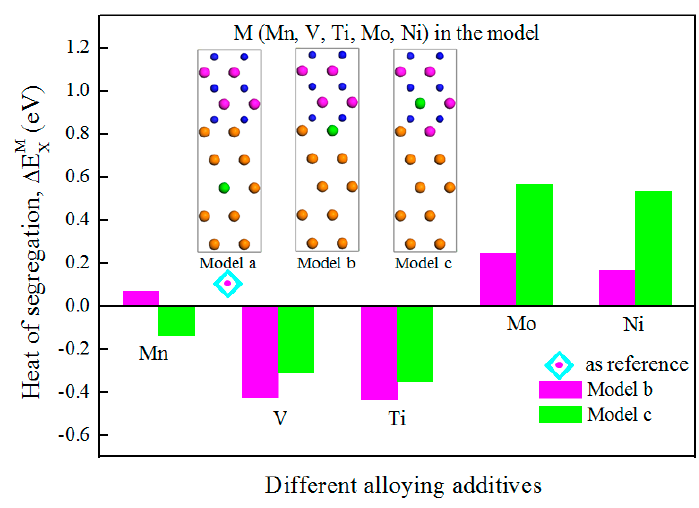
Figure 2. The heat of segregation ( ∆ E seg ) for the Fe(111)/Cr 2 N(0001) interface after M (M = Mn, V, Ti, Mo, and Ni) atom is introduced.